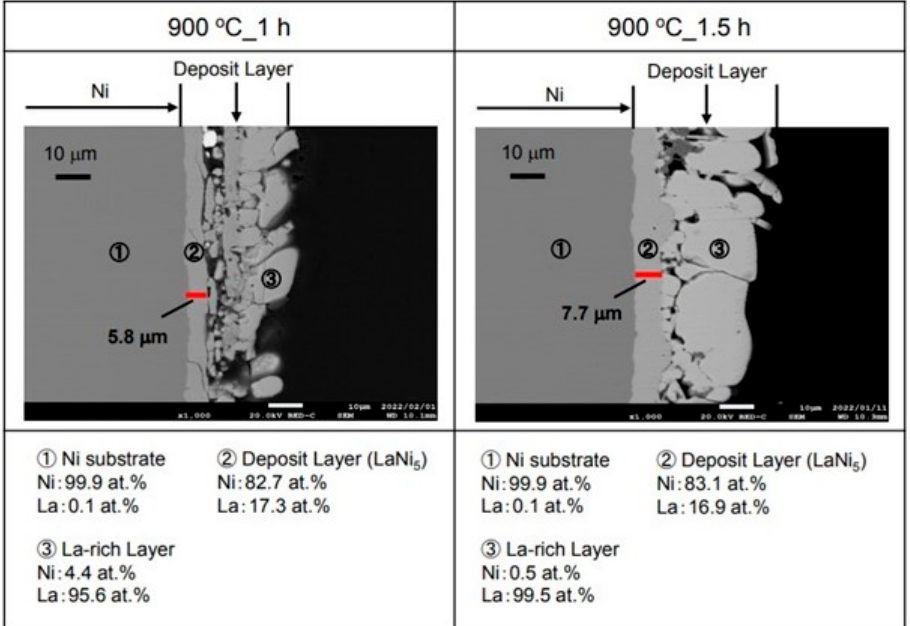
Figure 5. Cross-sectional microstructure and element analysis of Ni after La deposition at − 2.25 V in NaCl-KCl-5.0 mol%LaF 3 melts at 900 °C.